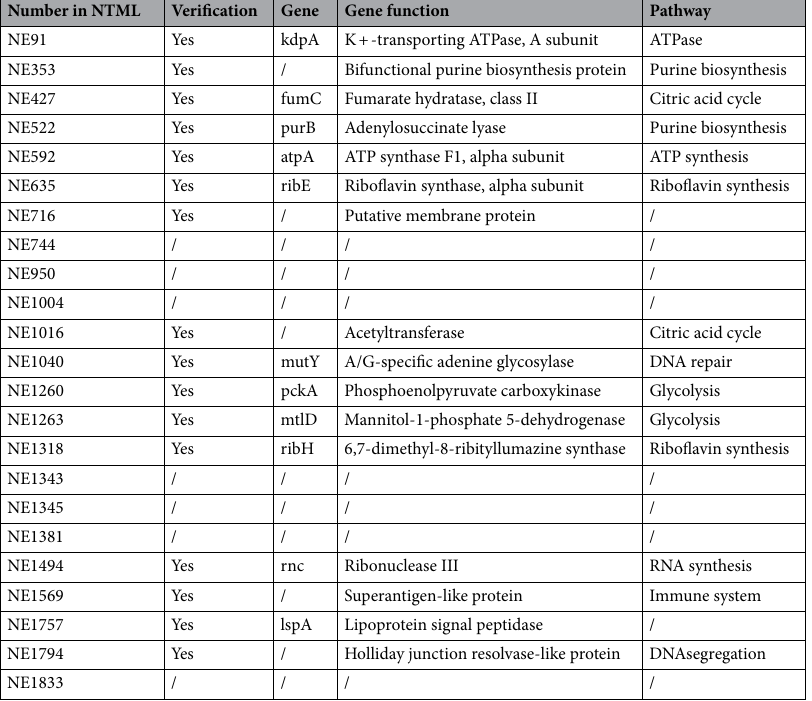
Table 2. NTML screening suggests energy metabolism as target of BAB. 0.5 × MIC of BAB was tested on each of the 1,920 strains and 23 inhibited strains were selected. These hits were verified with MIC assay and 16 strains indeed were hypersensitive to BAB. The mutated gene with its gene function and involved pathway for each of the 16 hits is